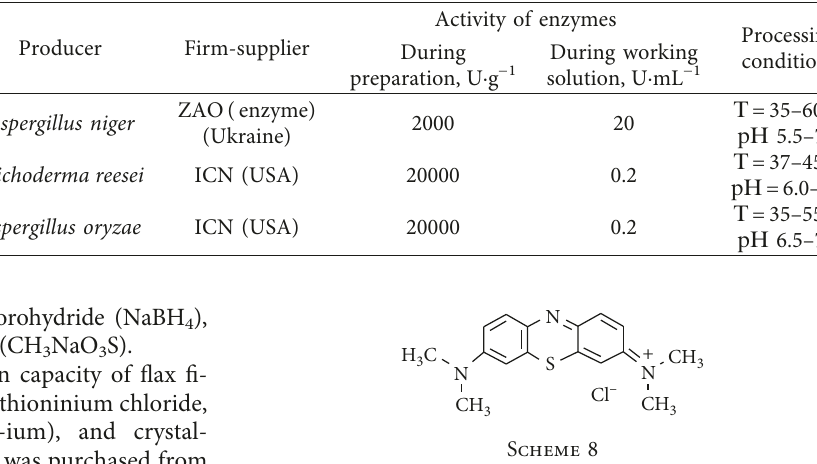
Table 1: Characteristics of enzyme